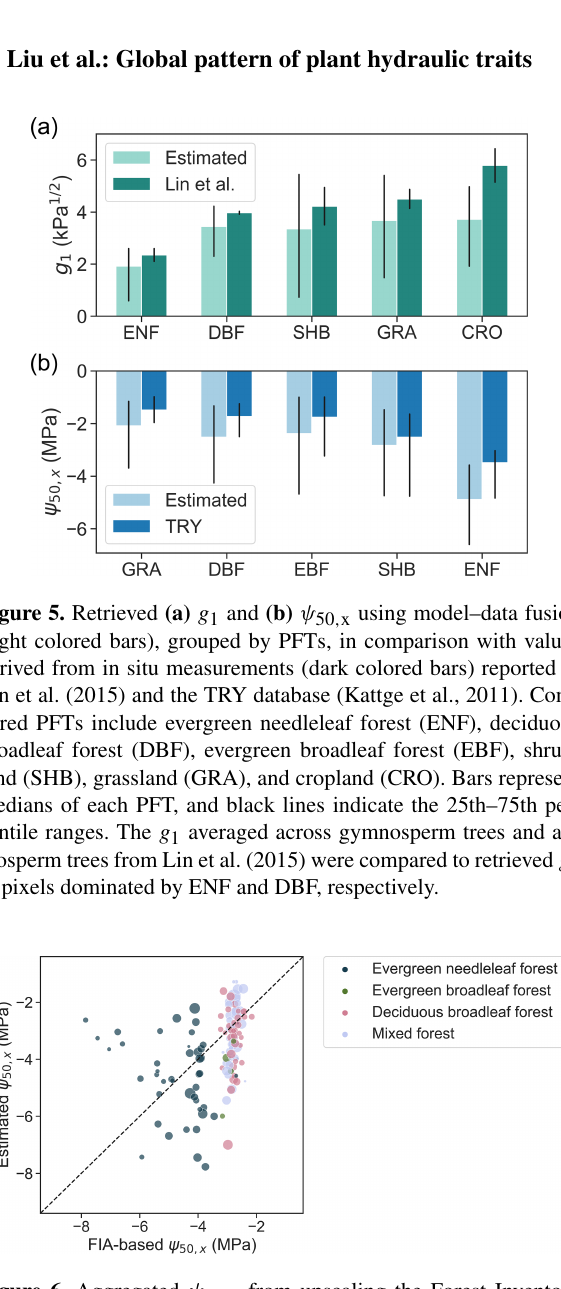
Figure 6. Aggregated ψ 50 , x from upscaling the Forest Inventory and Analysis (FIA) plots, based on Trugman et al. (2020), and ψ 50 , x retrieved here for corresponding pixels. The point size is scaled by number of plots used in aggregation for each